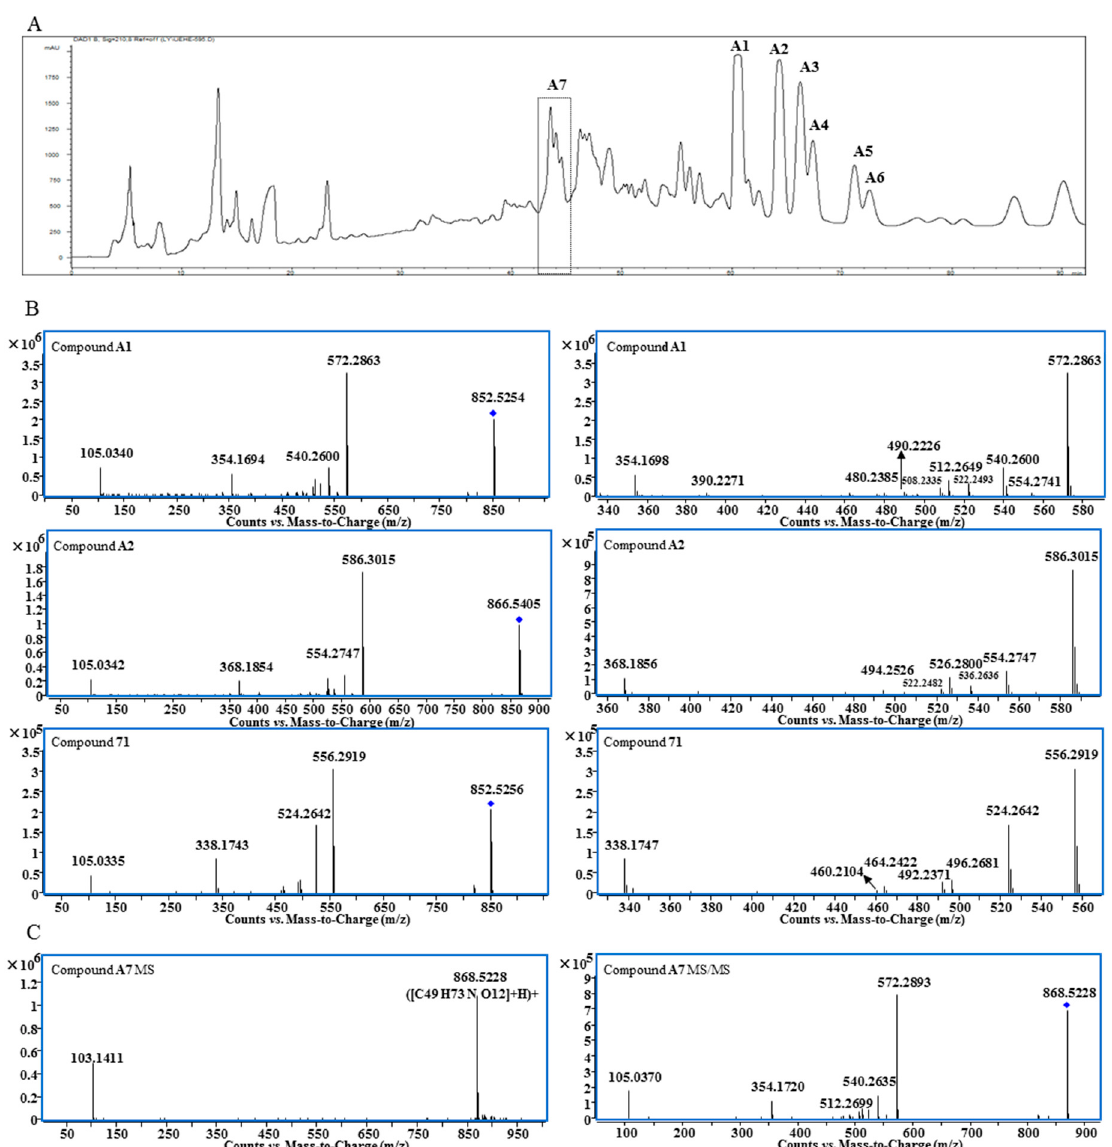
Figure 1. Preparative HPLC chromatogram of Fraction D4-1-8 ( A ); MS/MS and expanded MS/MS spectra of Compounds A1 , A2 and 71 ( B ); MS and MS/MS spectra of Compound A7 ( C ).